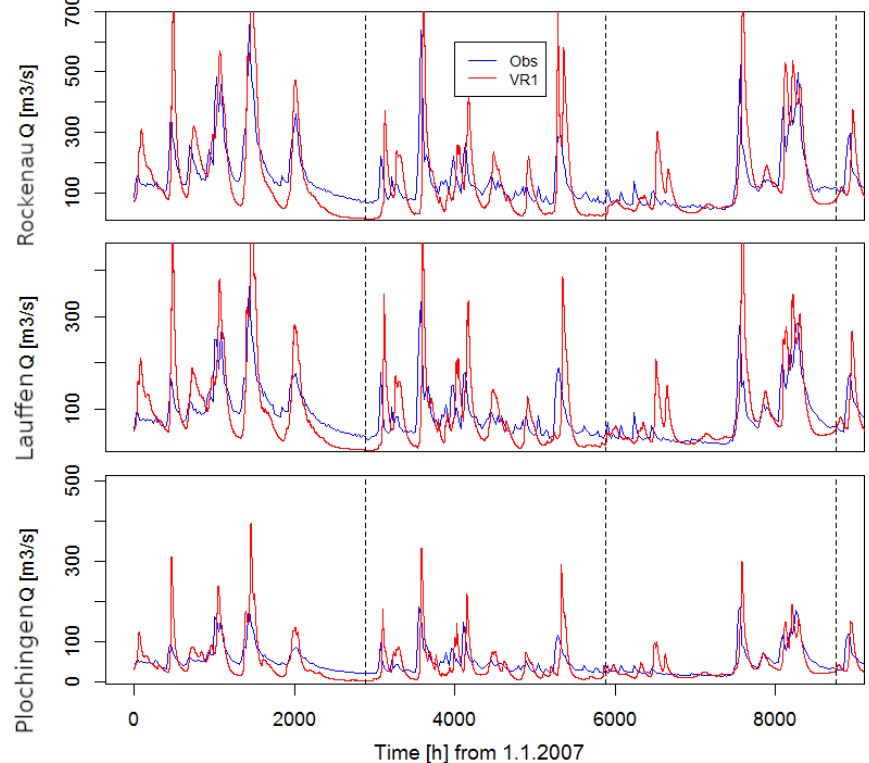
Figure 11. Hourly values river discharge at the gauging stations – Rockenau (P1), Lauffen (P2) and Plochingen (P3) – for the year 2007. Blue: observed; red: simulated